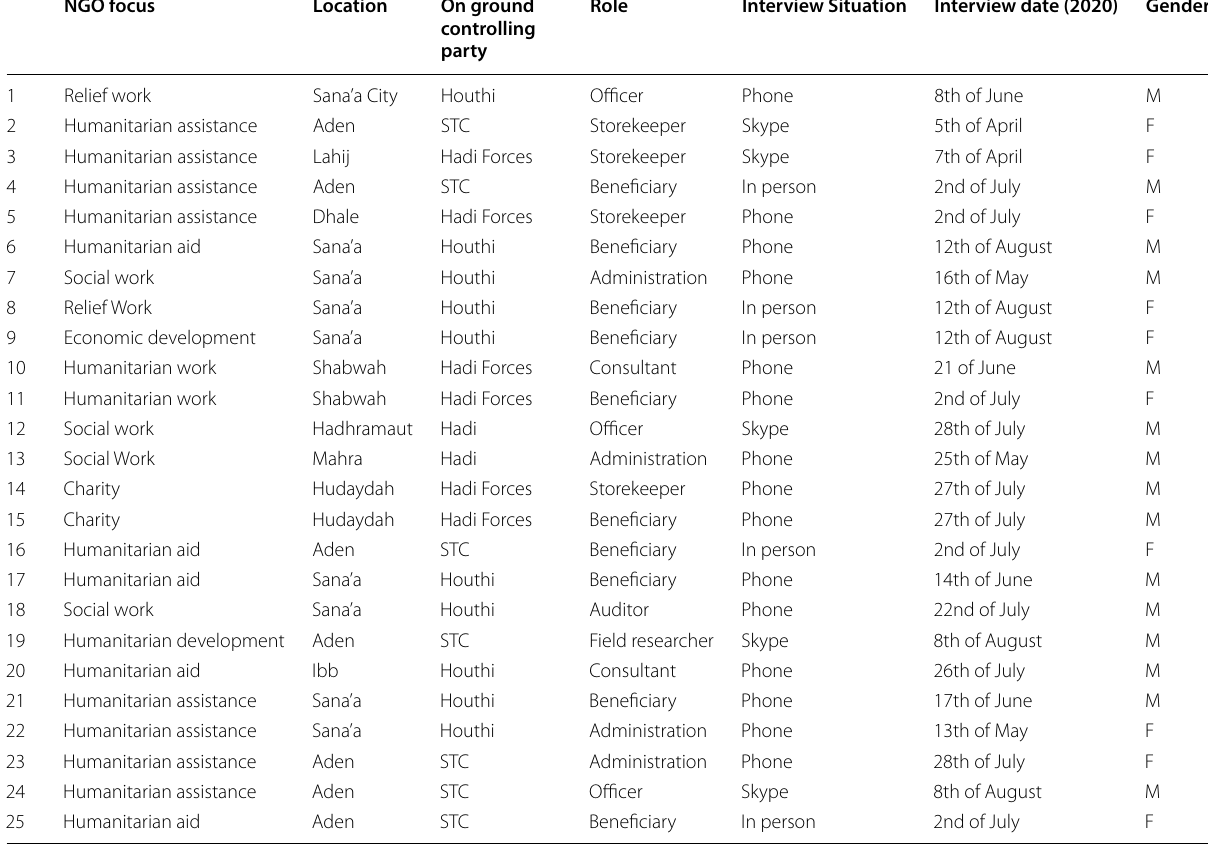
Table 2 Sample and